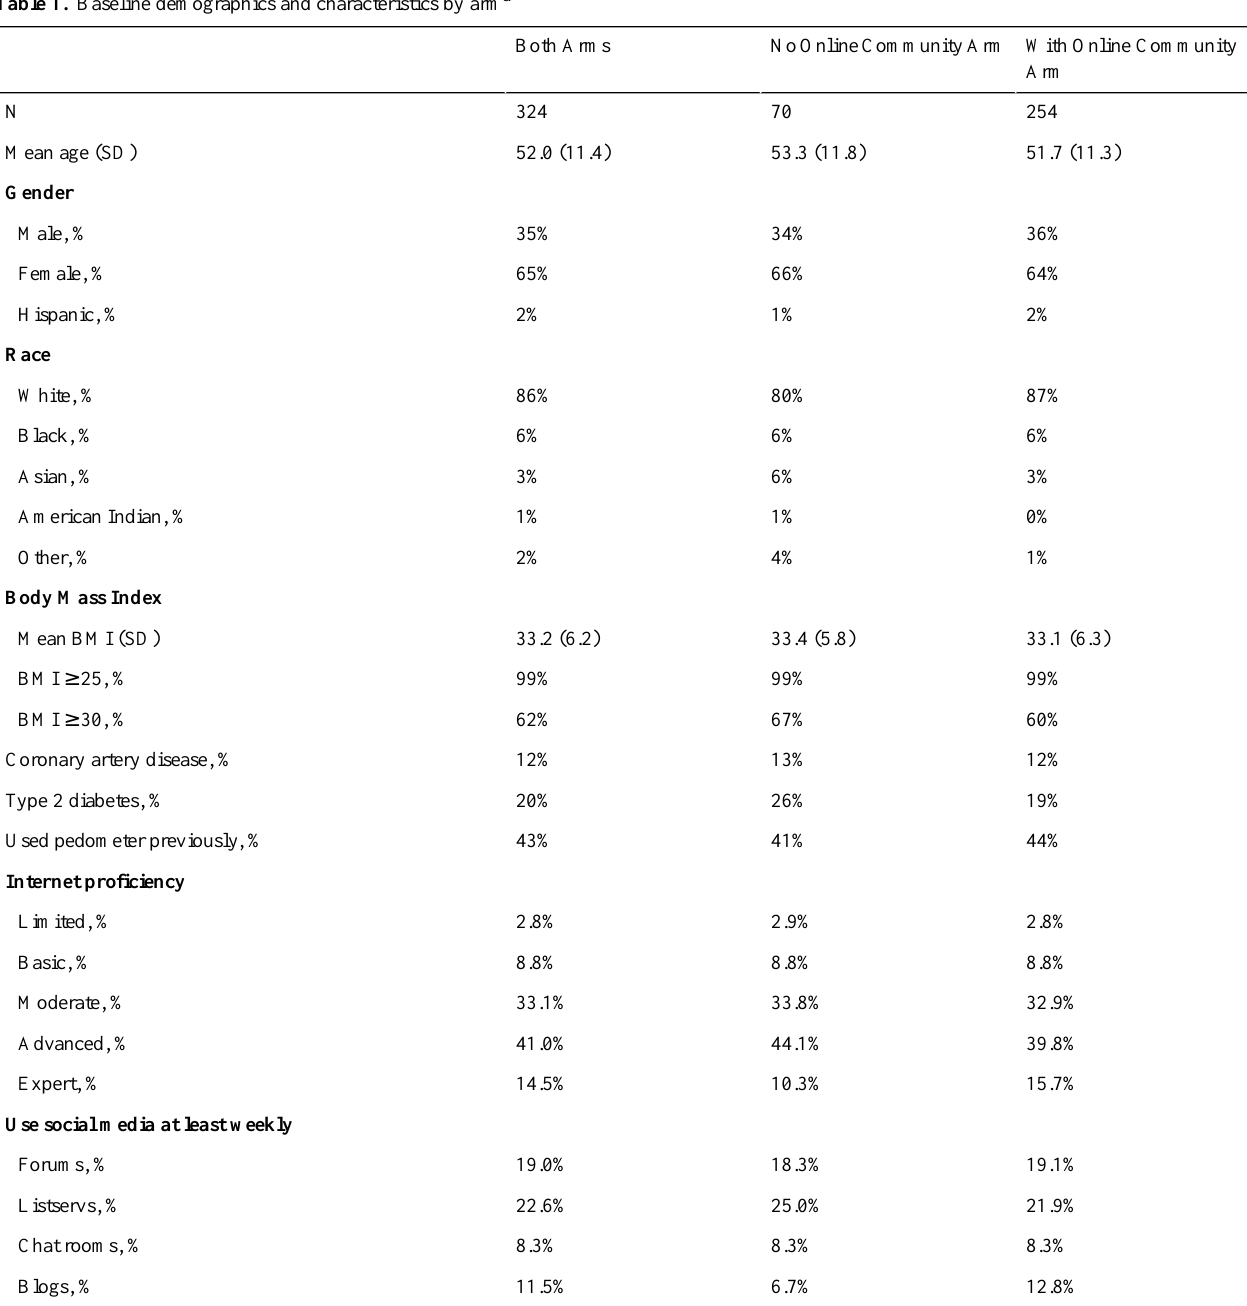
Table 1. Baseline demographics and characteristics by arm a